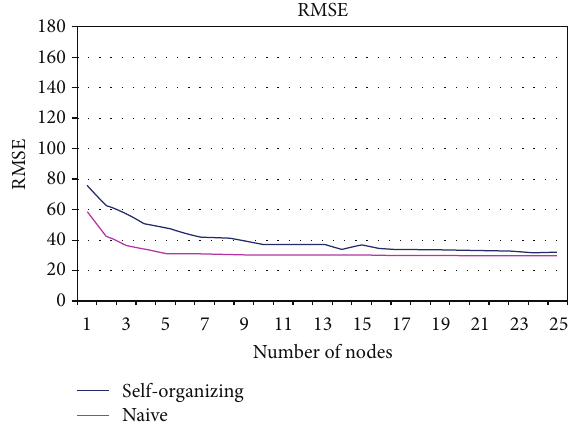
Figure 7: RMSE in spatiotemporal